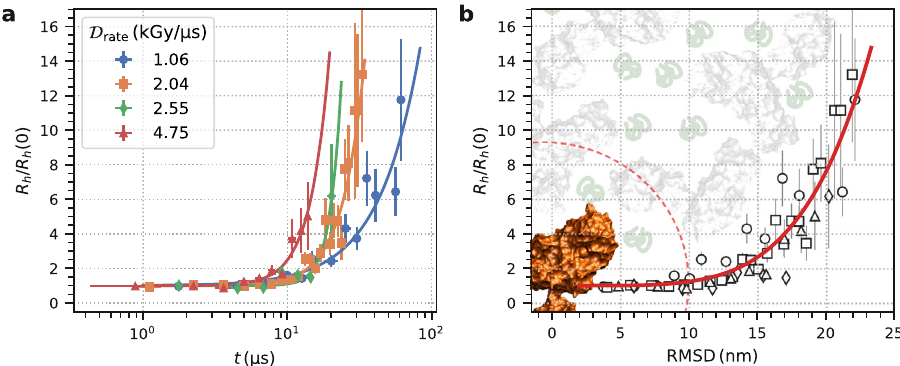
Fig. 6 | X-ray induced aggregation pathways. a Apparent hydrodynamic radii normalizedtotheinitialvalue R h (0)asafunctionofmeasurementtimefordifferent dose rates. The solid lines are guides to the eye. b Apparent hydrodynamic radii normalizedtotheinitialvalue R h (0)asafunctionofrootmeansquaredisplacement